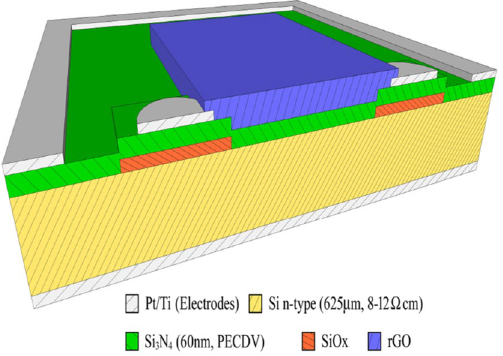
Figure 1. Schematic representation of the heterojunction cross section, formed by rGO (top surface) and Si (n-type) based substrate.